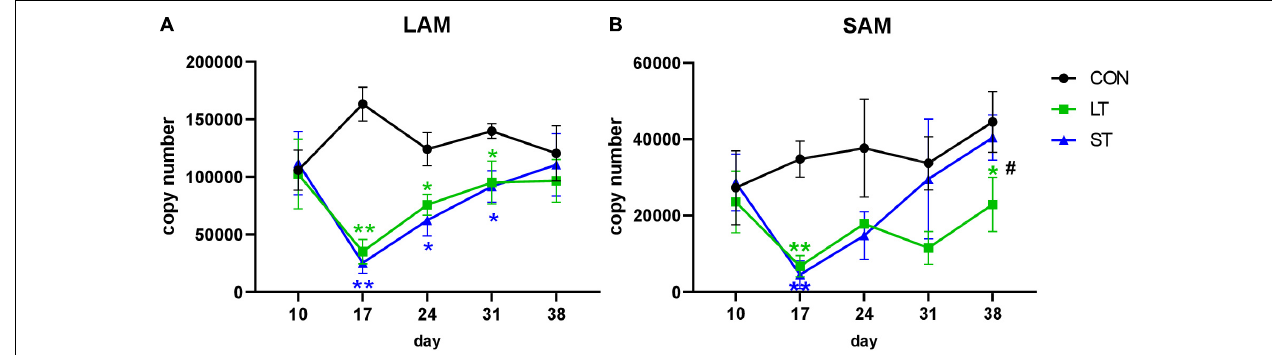
FIGURE 2 | Copy numbers of the mcrA gene in LAM (A) and SAM (B) samples. ST, short-term group; LT, long-term group; CON, control group. Significant treatment effects of LT or ST, compared to CON in Tukey post hoc test are indicated by ** P < 0.01, * P < 0.05. Significant treatment effects between ST and LT are indicated by # P < 0.05. Data are presented as means ±